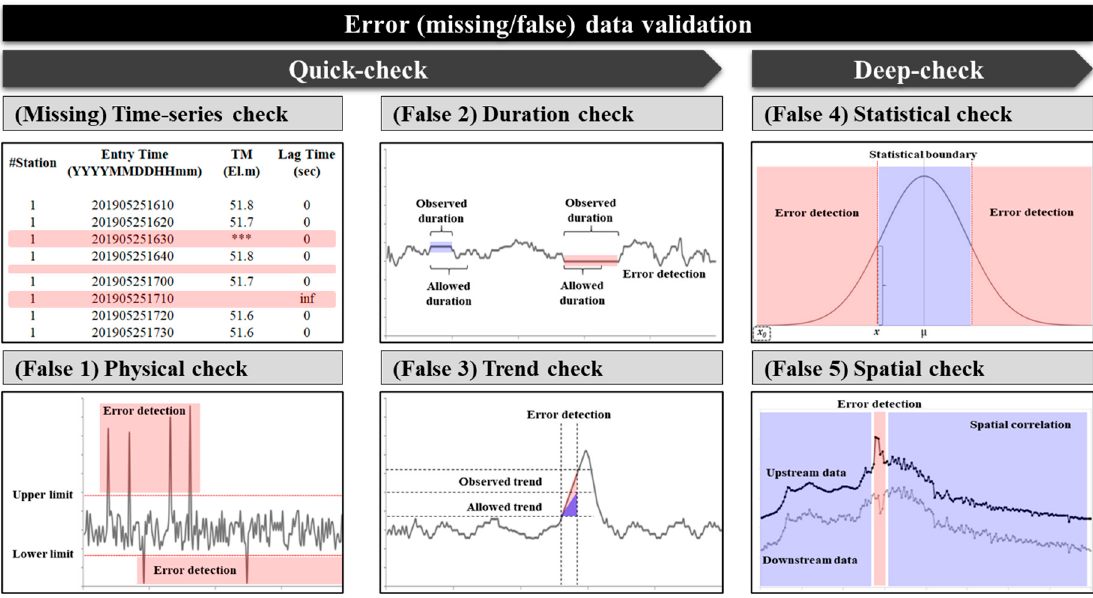
Figure 2. Conceptual diagram of the applied six data validation algorithms.